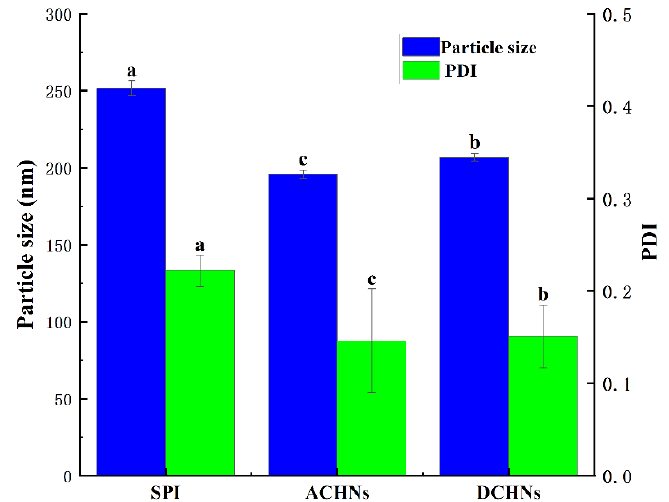
Figure 9. Particle size of modified soybean protein emulsion. Different letters in the same column indicate a significant difference ( p <0.05). Table 3. Particle size and zeta-potential of modified soybean protein emulsion.